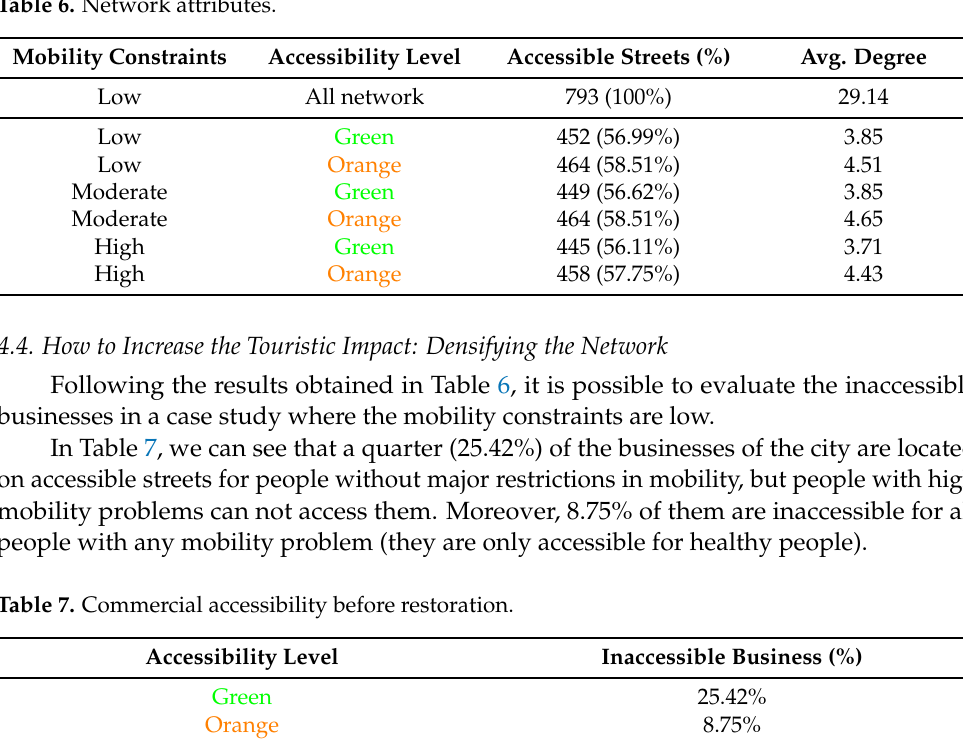
Table 6. Network attributes.